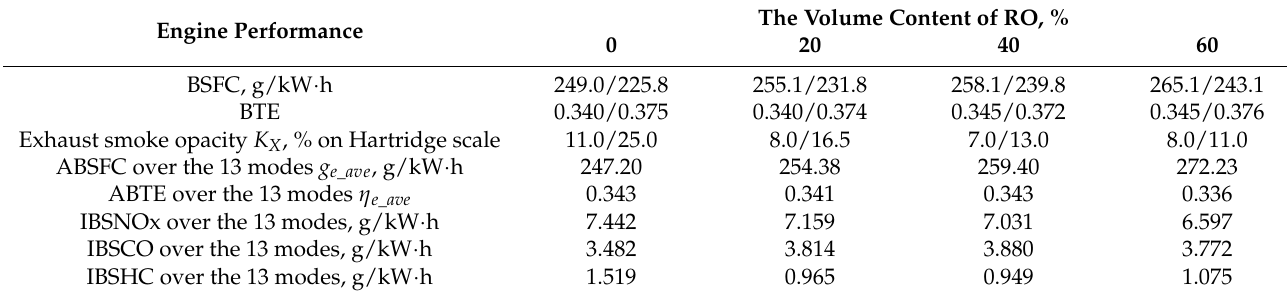
Figure 5. Dependence of brake power N e , brake torque M e , hourly fuel consumption G f , excess air ratio α , exhaust smoke opacity K x , and BSFC g e on the engine speed n of the diesel engine D-245 in the operating conditions of the external characteristic curve for pure DF and R20. Table 6. Performances of the diesel engine D-245 running on pure DF and DF-RO blends in the operating conditions of the external characteristic curve and 13-mode test